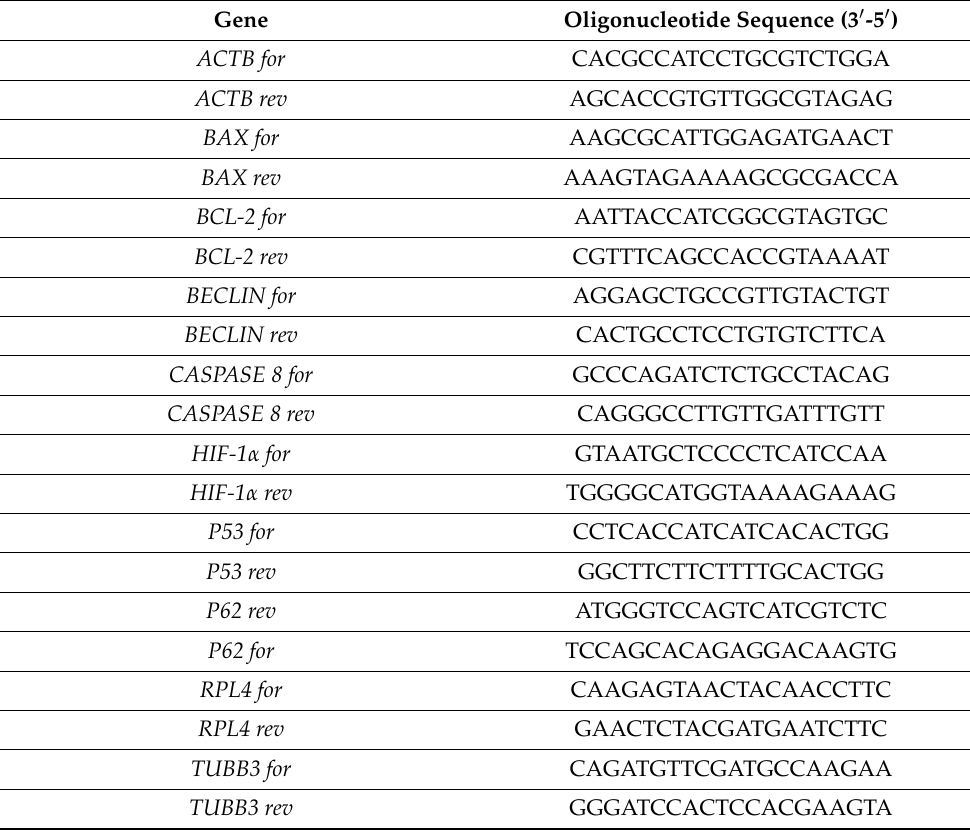
Table 2. Primer pairs used in RT-qPCR analyses. Abbreviations: for = forward; rev =